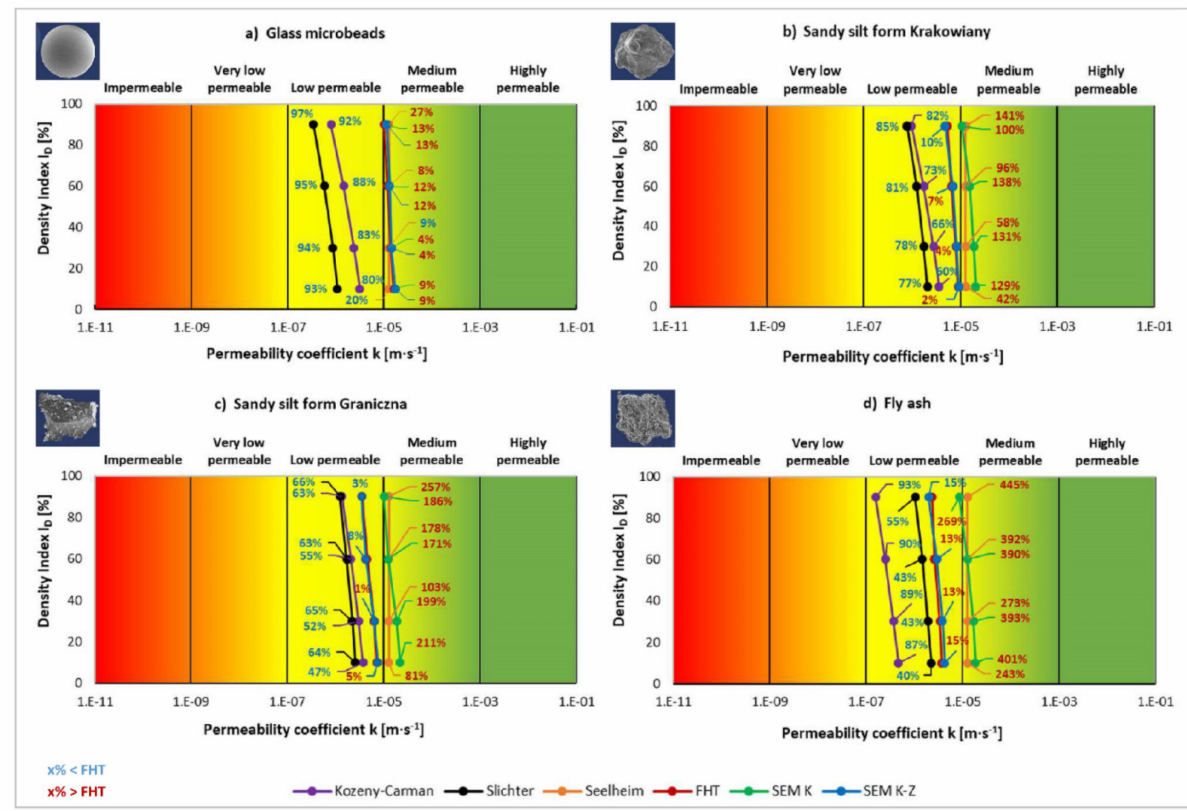
Figure 9. Purpose-made classification of engineering-geological environment permeability (suitable—green, conditionally suitable—yellow, unsuitable—red) based on permeability coefficient, where high permeability is perceived as a positive property of rock